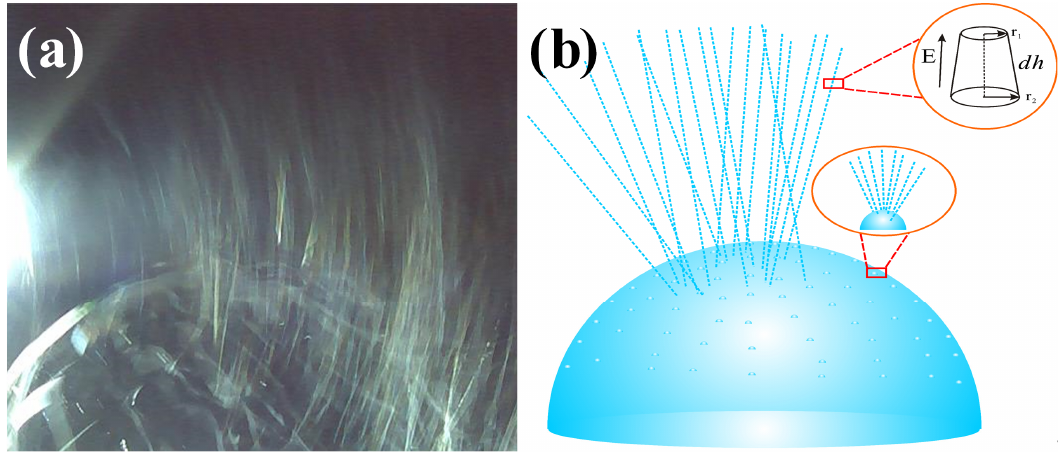
Figure 6. ( a ) Jet formation and ( b ) its mechanism in critical bubble electrospinning (7 wt % PVA solution).